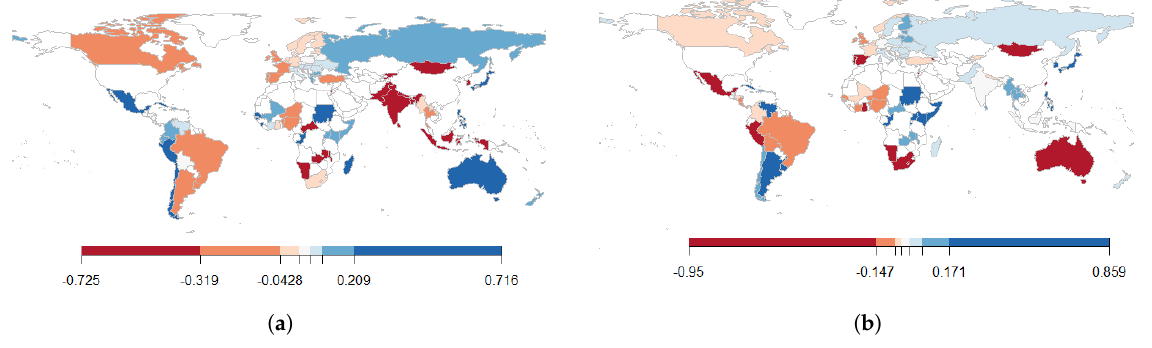
Figure 4. Democratic survival application spatial frailty maps: ( a ) depicts the posterior mean estimates of V (split − stage spatial frailties) and ( b ) depicts the posterior mean estimates of W (survival − stage spatial